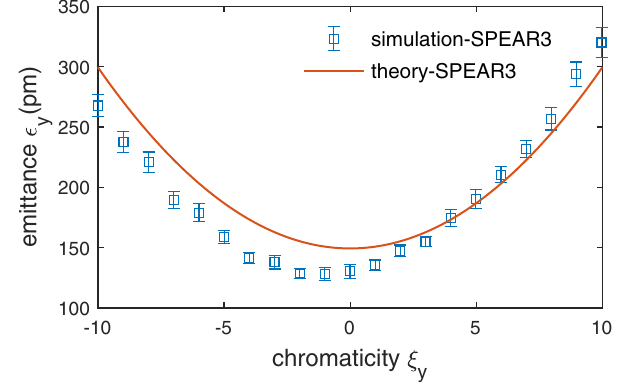
FIG. 3. Vertical emittance as a function of vertical chromaticity at vertical tune ν y ¼ 6 . 22 for the SPEAR3 storage ring, simu- lation compared to